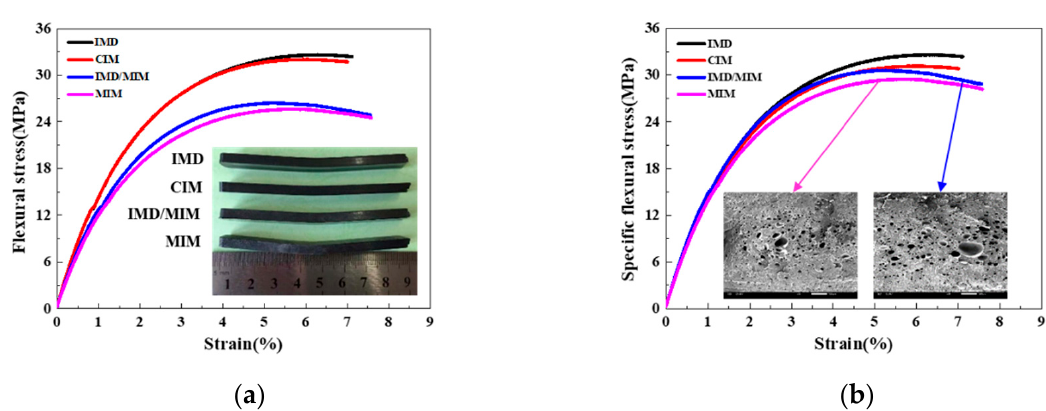
Figure 9. The flexural properties of the IMD, CIM, IMD/MIM and MIM samples: ( a ) flexural stress-strain curves; ( b ) specific flexural stress-strain curves.